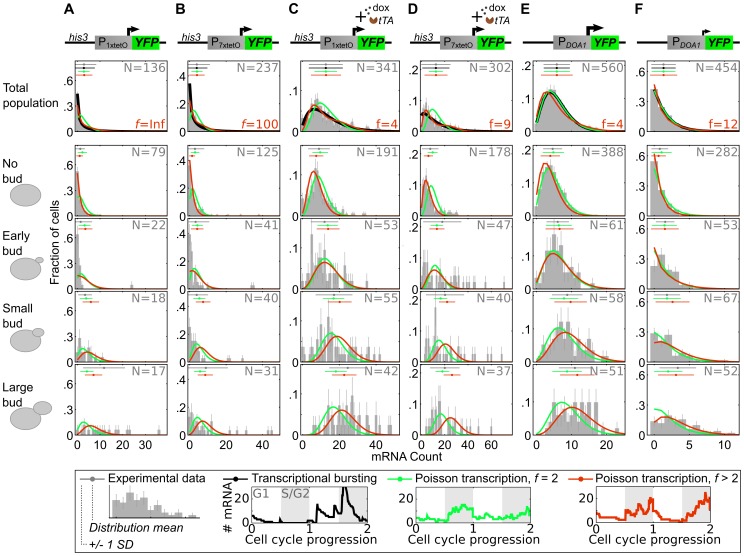
Large differences in transcriptional activity between S/G2/M and G1 depend on promoter.(A) YFP mRNA distributions in a haploid yeast with integrated P1xtetO-YFP and no tTA are shown in a column as a function of cell-cycle phase. Horizontal lines above each distribution are the experimental (gray) and predicted mean/standard deviation for different models, with colors shown in the legend at the bottom, calculated by assuming each bud phase represents 1/3 of S/G2/M. (B) As in (A) but with P7xtetO. (C&D) As in (A&B) but with tTA and 100 or 500 ng/mL dox added for P1xtetO and P7xtetO, respectively. (E) Integrated PDOA1-YFP with native DOA1 expressed from a plasmid. Mid log-phase cells were analyzed. (F) As in (E) but late log-phase cells.